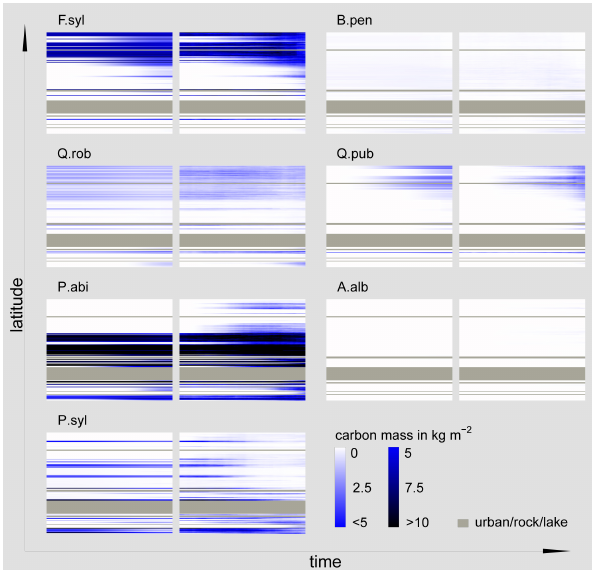
Figure D7. Carbon mass development along the analyzed transect of seven selected species using the stochastic (100 stochastic replicates) LPJ-GUESS approach (right) and the GAPPARD method (left), both with the standard parameter set. The timescale in each plot extends from 1900 (left side) to 2100 (right side). See Fig. D3 for species abbreviations.